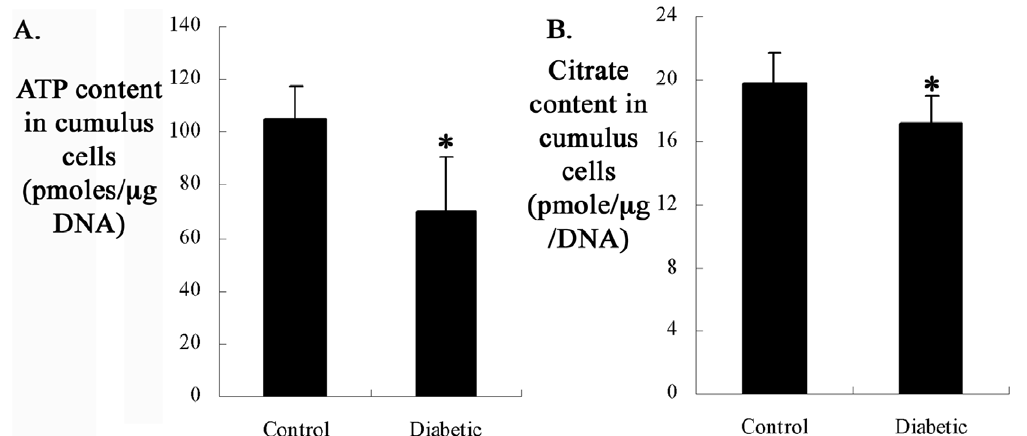
Figure 5. Reduced ATP and citrate content in cumulus cells of diabetic mice. Cumulus cells removed from cumulus-oocyte complexes were collected to determine the levels of ATP and citrate. Values are expressed as pmoles per m g DNA. (A–B) Histogram shows the average ATP and citrate content in cumulus cells from control and diabetic mice. All measurements were performed in triplicate. Error bars indicate 6 SD. * p , 0.05 vs controls.